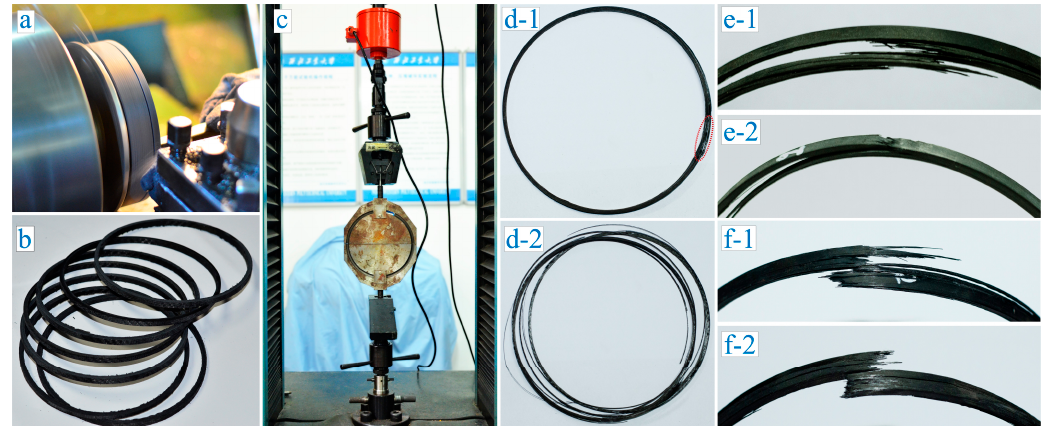
Figure 2. Experimental test samples machining and tensile strength testing process. ( a ) Turning machining process; ( b ) Standard testing rings; ( c ) Split disc tensile tests on electronic universal testing machine DDL100; ( d – f ) Typical failure mode of the ring specimen.